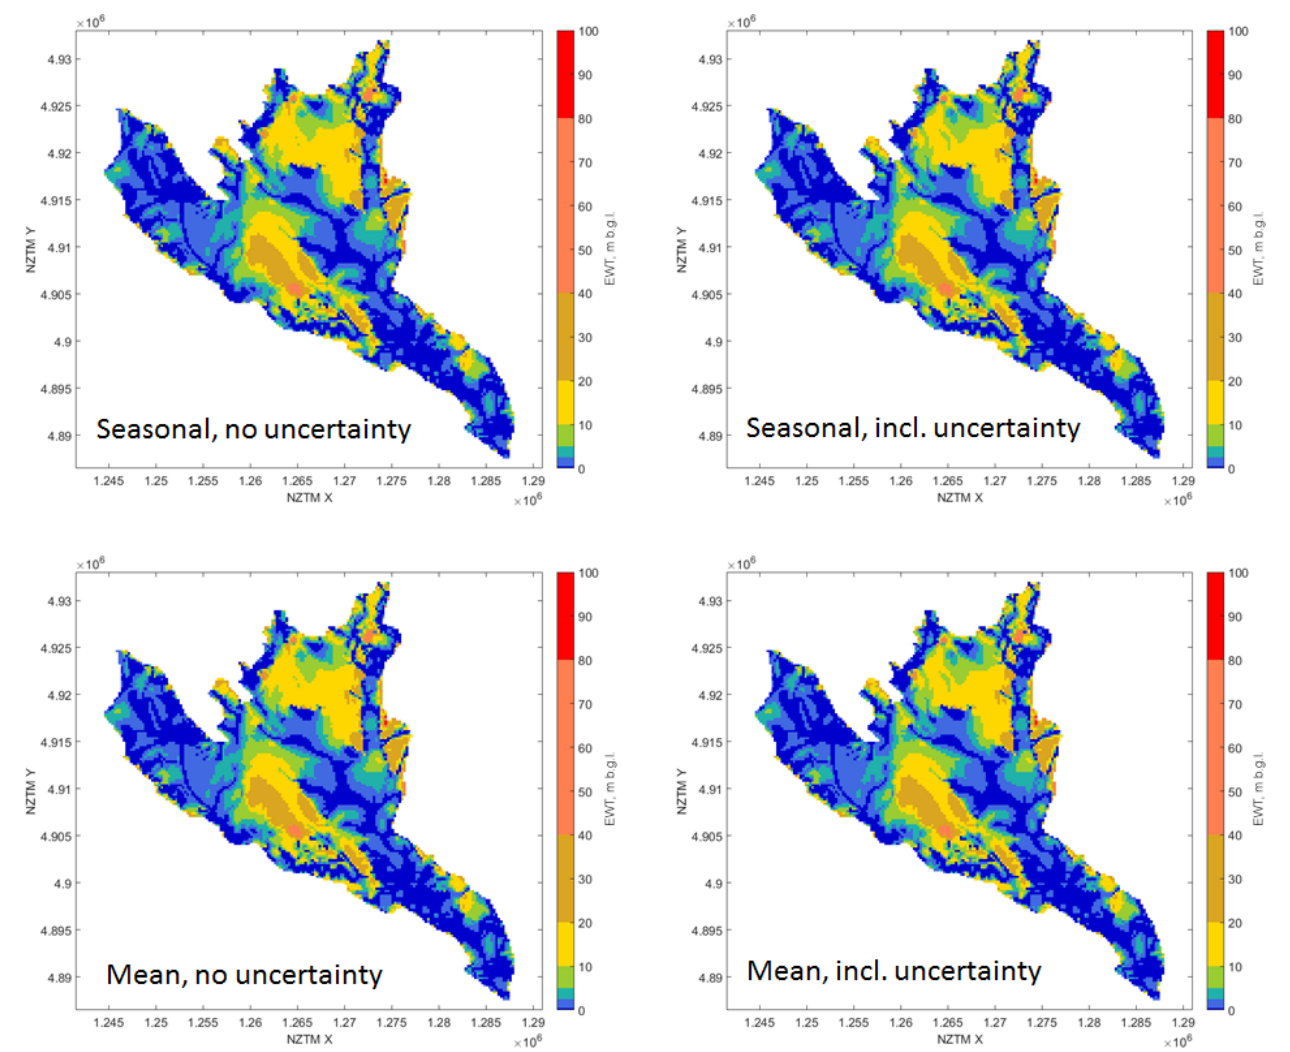
Figure B3. Convergence test in the Mataura catchment, Southland, New Zealand, with inclusion of uncertainty and a Gaussian distribution over the year to include seasonality of